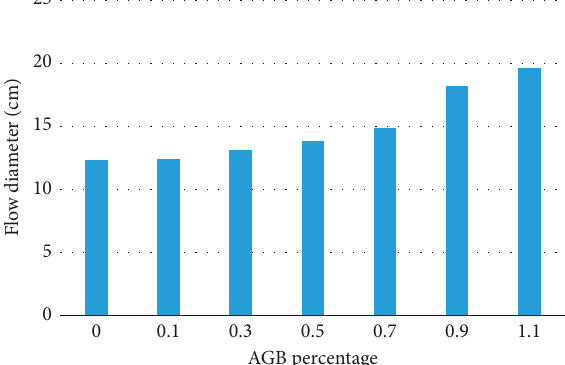
Figure 3: Flow diameter as a function of AGB content.